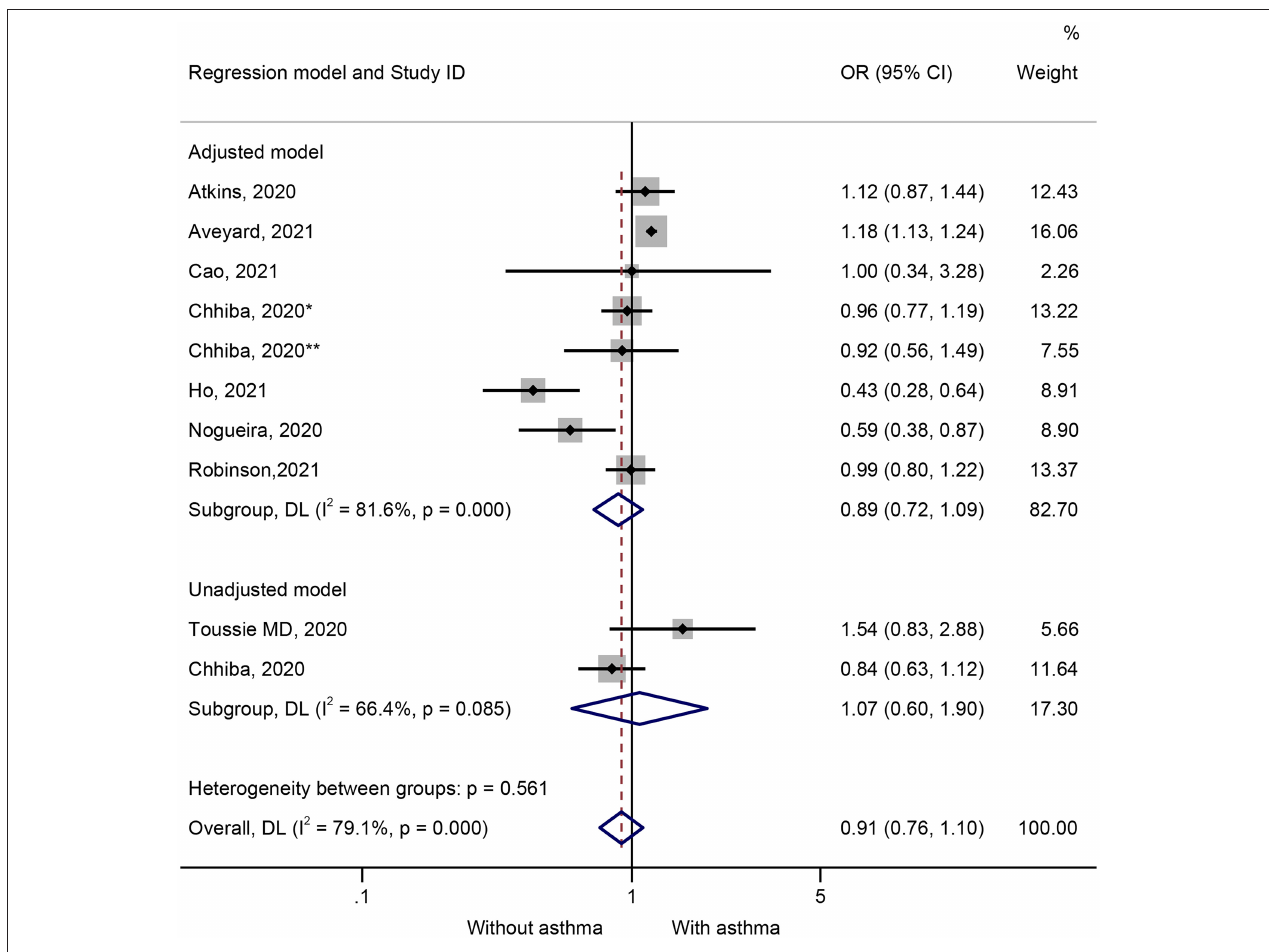
FIGURE 4 | Forest plot of hospitalization comparing patients with or without preexisting asthma by the model applied. Weights and between-subgroup heterogeneity test are from random-effects